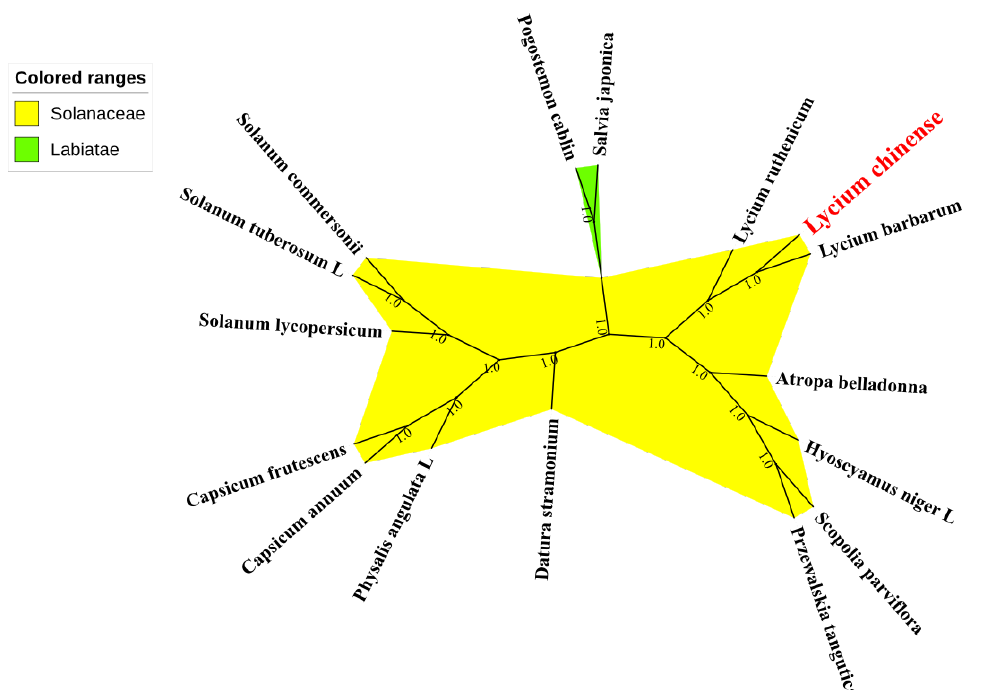
Figure 6. Phylogenetic relationships among 16 species inferred using maximum likelihood analyses of the complete chloroplast genome, excluding IRa regions. Numbers at nodes are values for bootstrap support. The position of L. chinense is indicated in red font. Sequences from Salvia japonica Thunb and Pogostemon cablin (Blanco) Ben were set as out group.